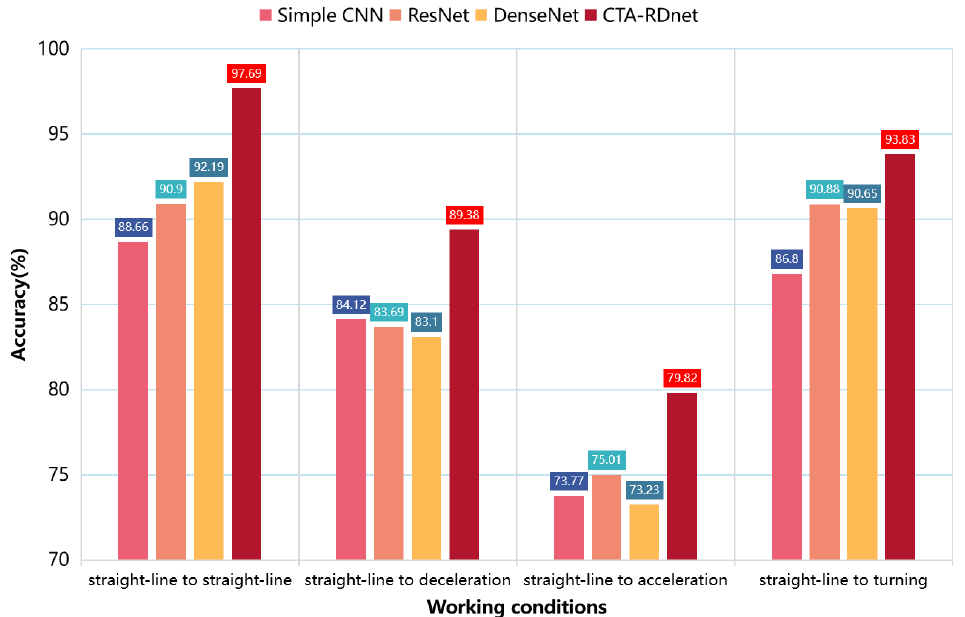
Figure 14. The recognition accuracy of different models under mismatching working conditions (straight line).